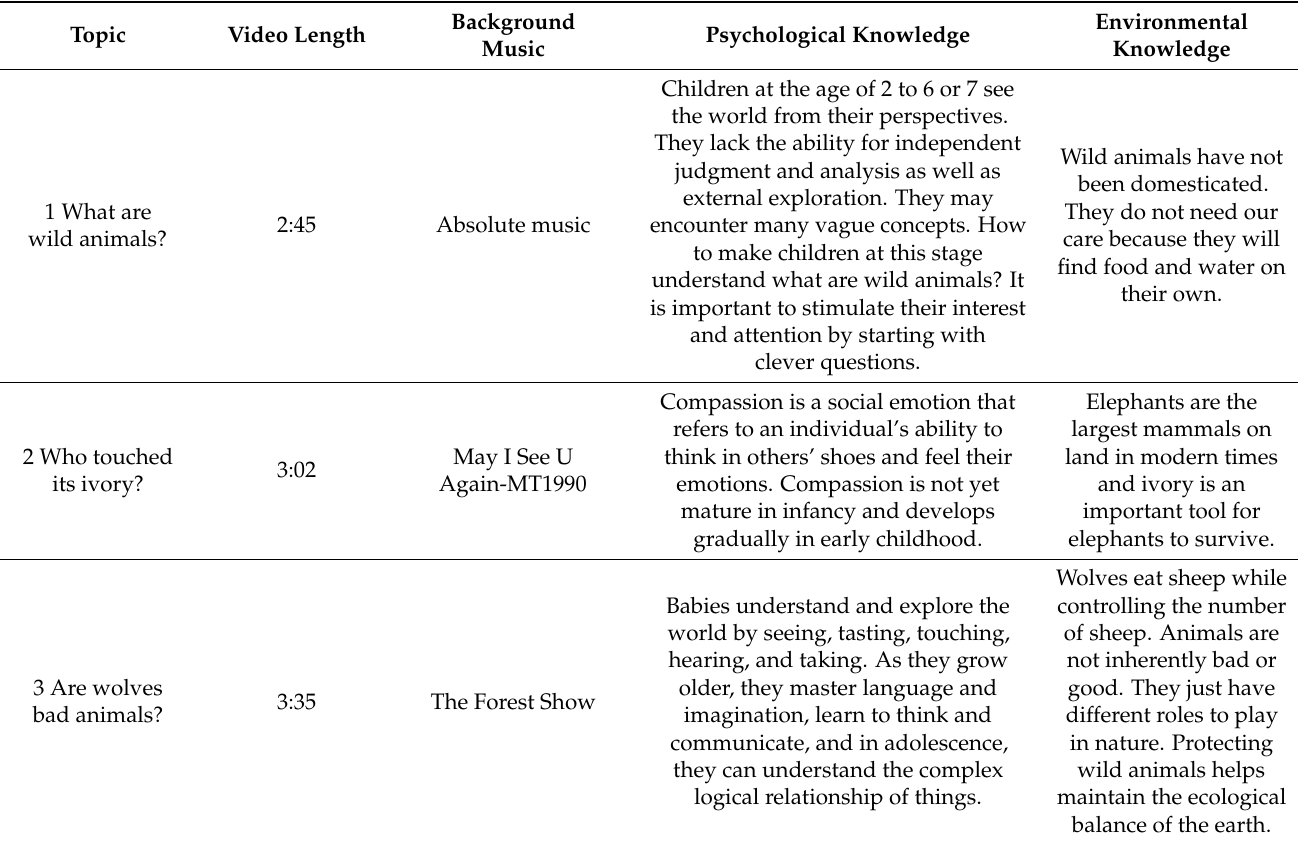
Table A1. The content of experimental materials for each